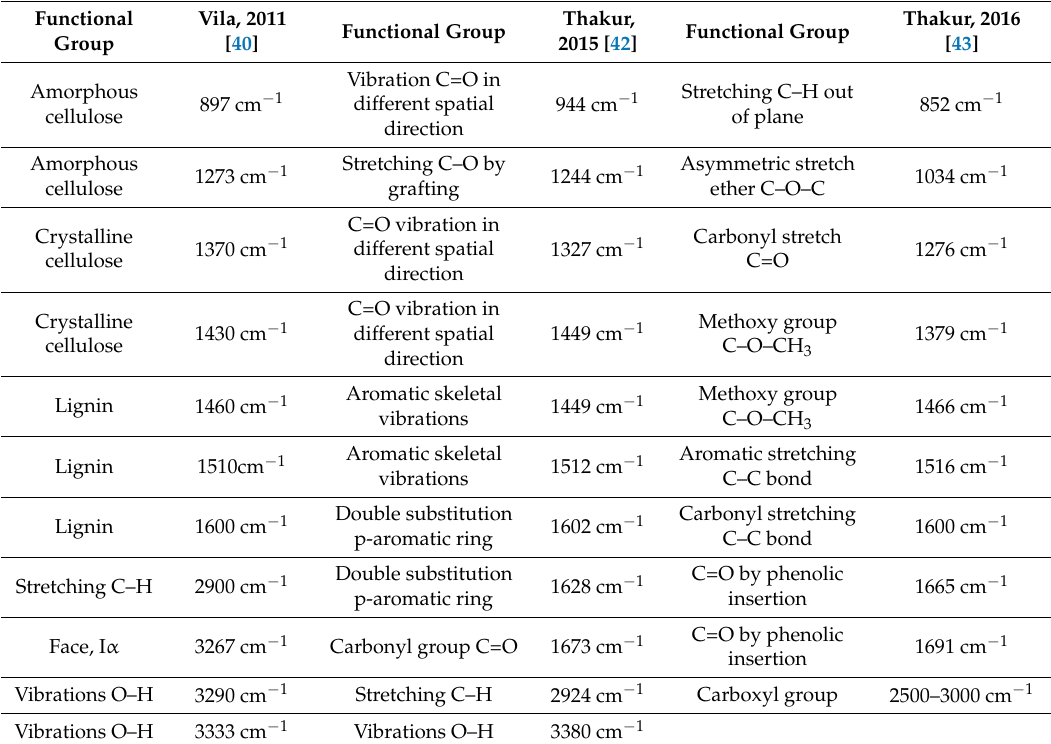
Table 2. FTIR assignments for the spectra acquired.